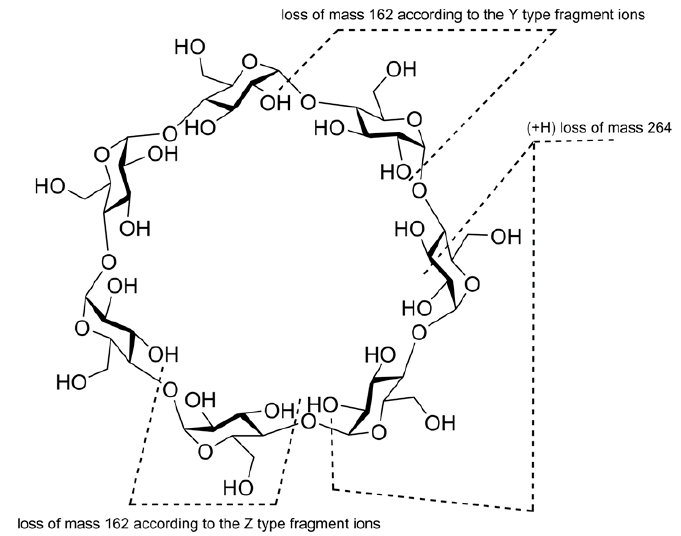
Figure 5. Fragmentation of [ β -CD + Cat] 2+ ions according to [33].